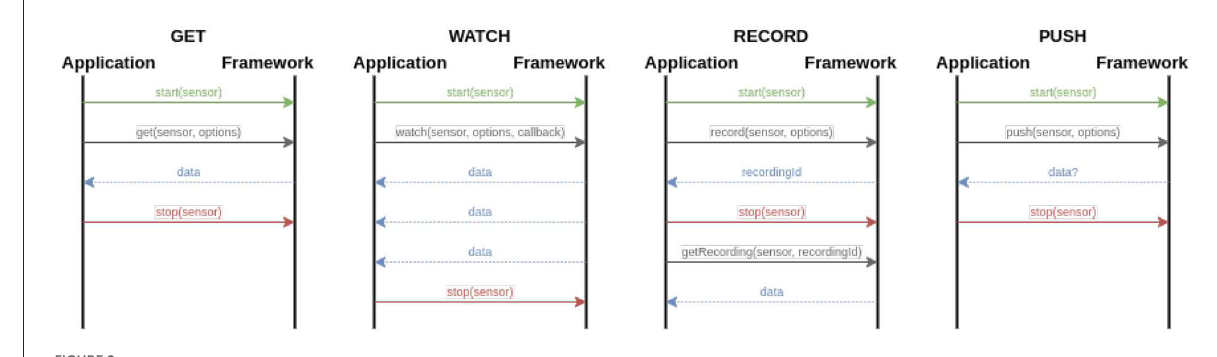
FIGURE2 Identified and implemented sensor interaction